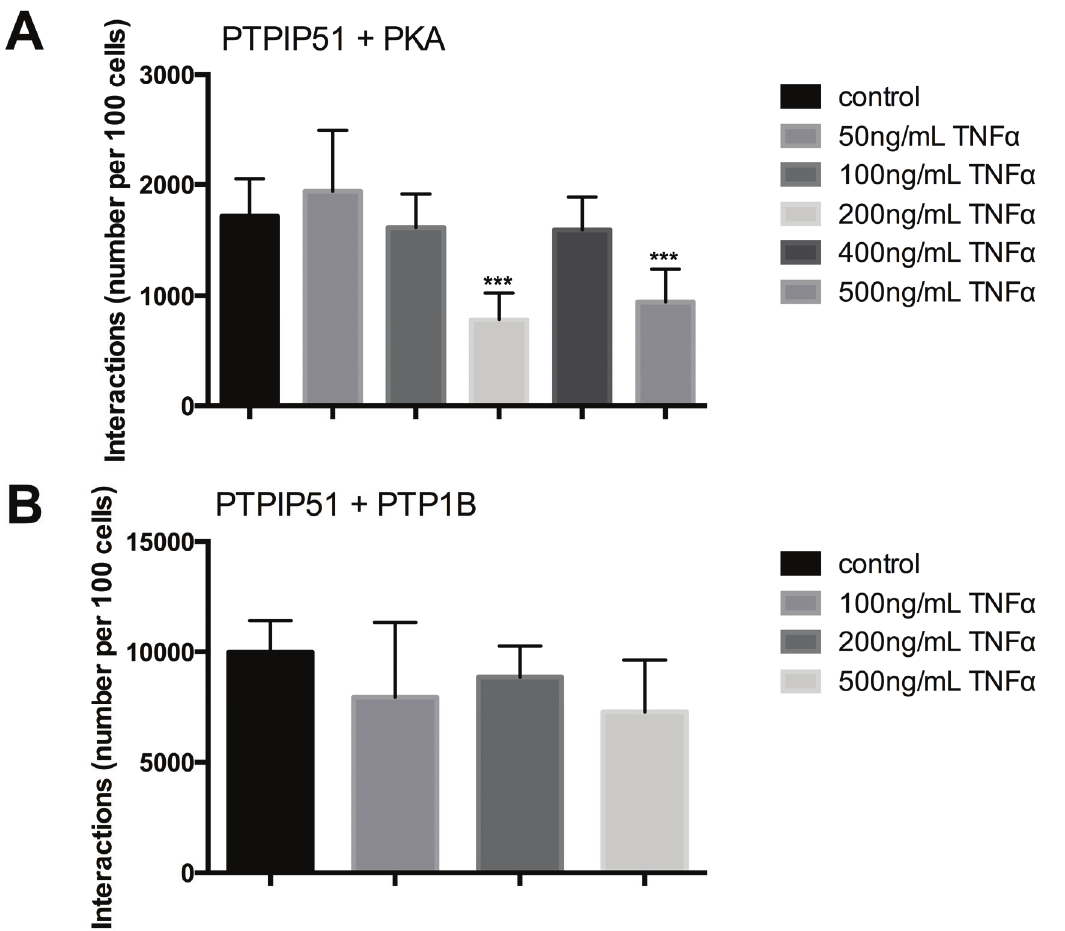
Figure 9. Quantitative analysis of PTPIP51 and PKA, PTPIP51 and PTP1B interactions evaluated by Duolink Image Tool software. ( A ) PTPIP51 and PKA interactions. Untreated controls, 50 ng/mL TNF(cid:3) treated cells, 100 ng/mL TNF(cid:3) treated cells, 200 ng/mL TNF(cid:3) treated cells, 400 ng/mL TNF(cid:3) treated cells, 500 ng/mL TNF(cid:3) treated cells. *** ( p < 0.001); ( B ) PTPIP51 and PTP1B interactions. Untreated controls, 50 ng/mL TNF(cid:3) treated cells, 100 ng/mL TNF(cid:3) treated cells, 200 ng/mL TNF(cid:3) treated cells, 400 ng/mL TNF(cid:3) treated cells, 500 ng/mL TNF(cid:3) treated cells. The resulting data were analyzed by GraphPad Prism